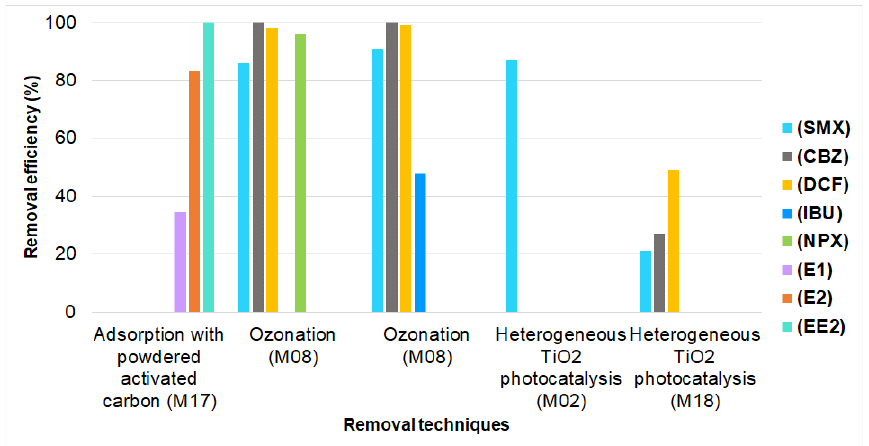
Figure 5. Removal of pharmaceuticals from municipal wastewater in studies with a pure experimental design (M17 = [49], M08 = [34], M02 = [28], M18 = [50]).